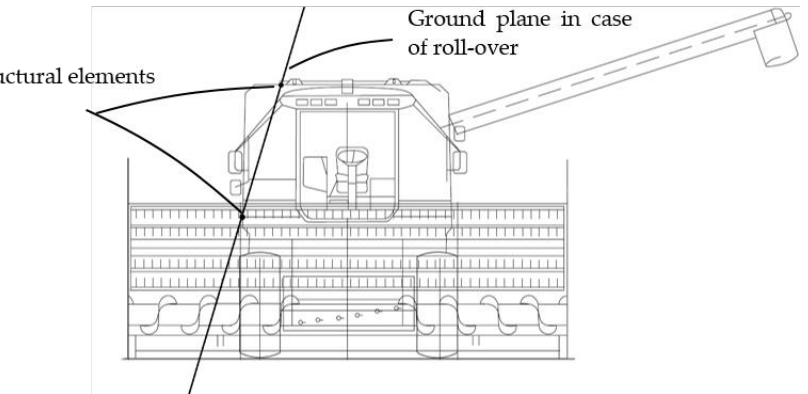
Figure 2. Structural elements of a combine harvester that should protect the operator in case of